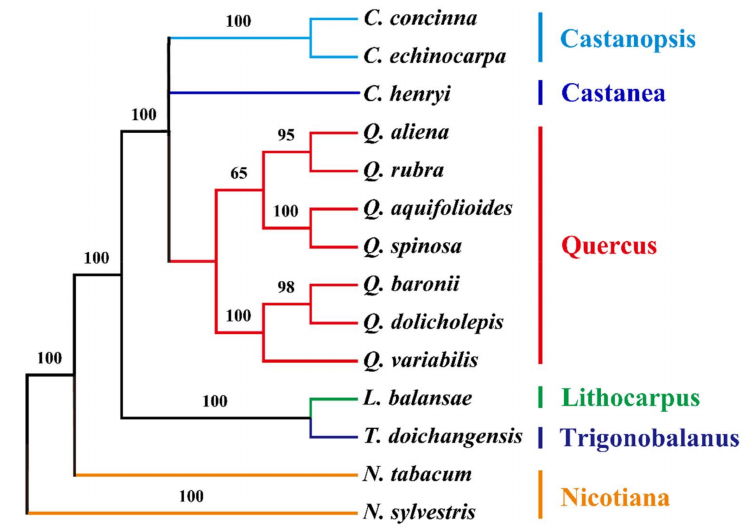
Figure 9. Phylogenetic relationship between Q. aquifolioides and related species, inferred from 73 protein-coding genes shared by all cp genomes. The phylogenetic tree was constructed by the maximum parsimony method, with two Nicotiana species as